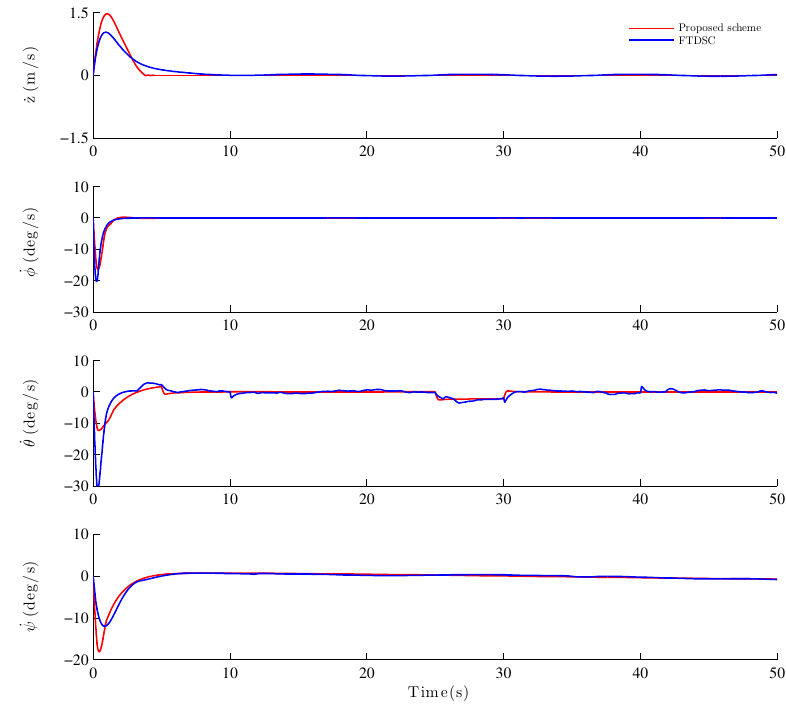
Figure 4. Time response of linear/angular velocity.